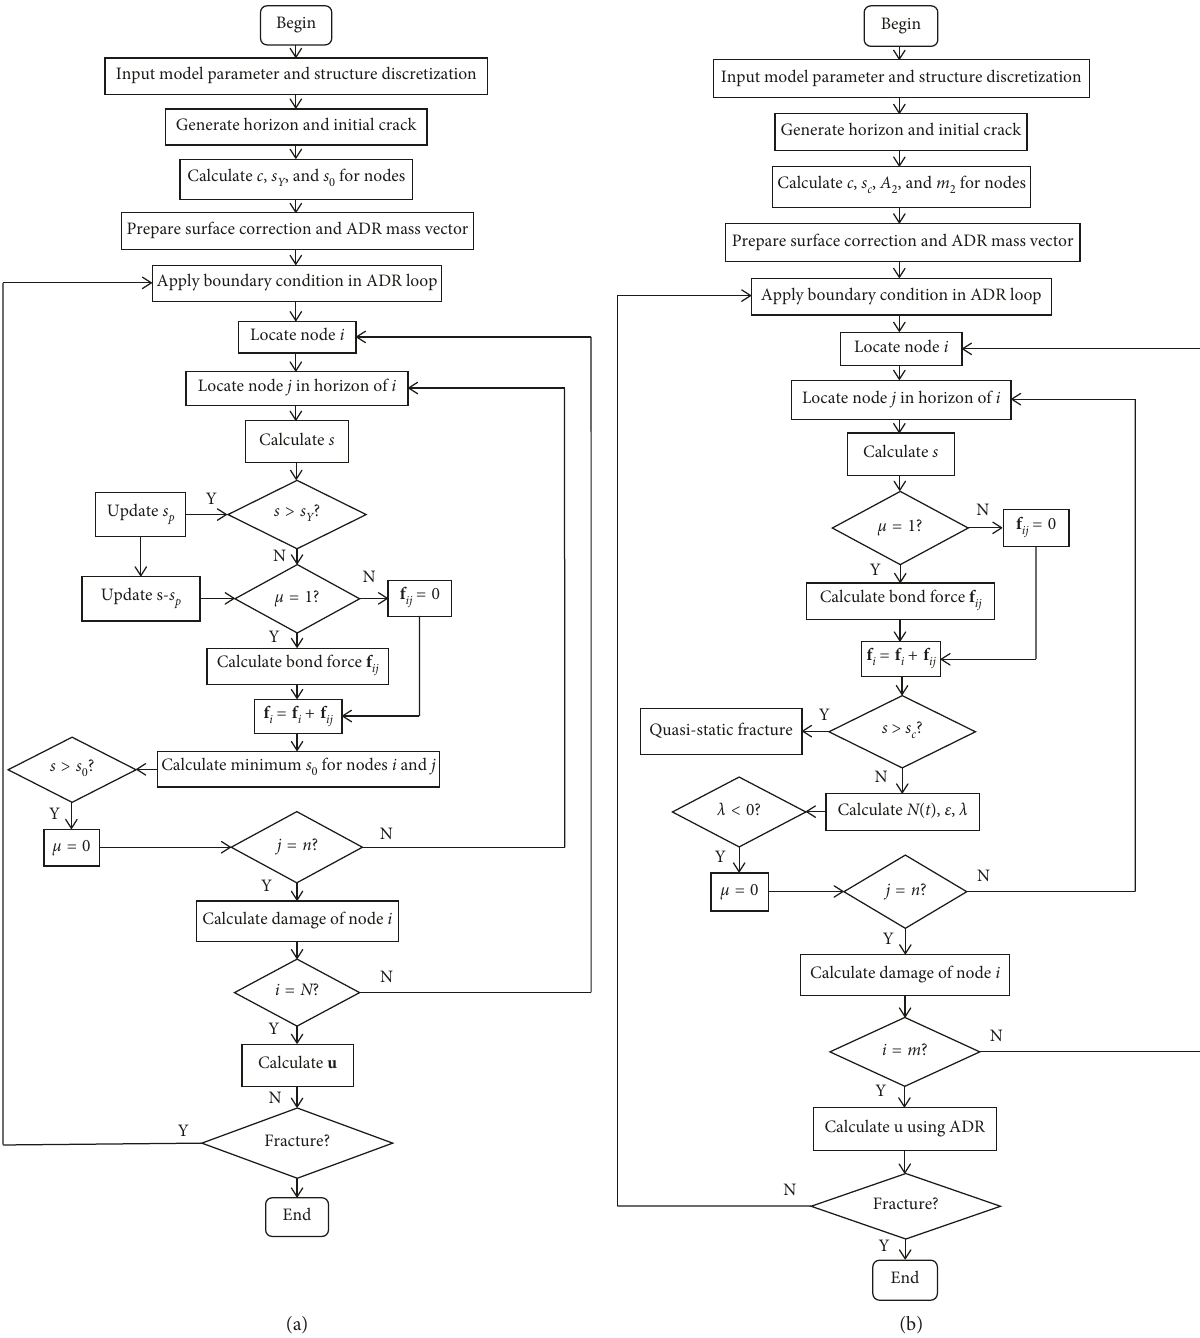
Figure 3: Peridynamic numerical implementations. (a) Quasistatic fracture algorithm. (b) Fatigue fracture